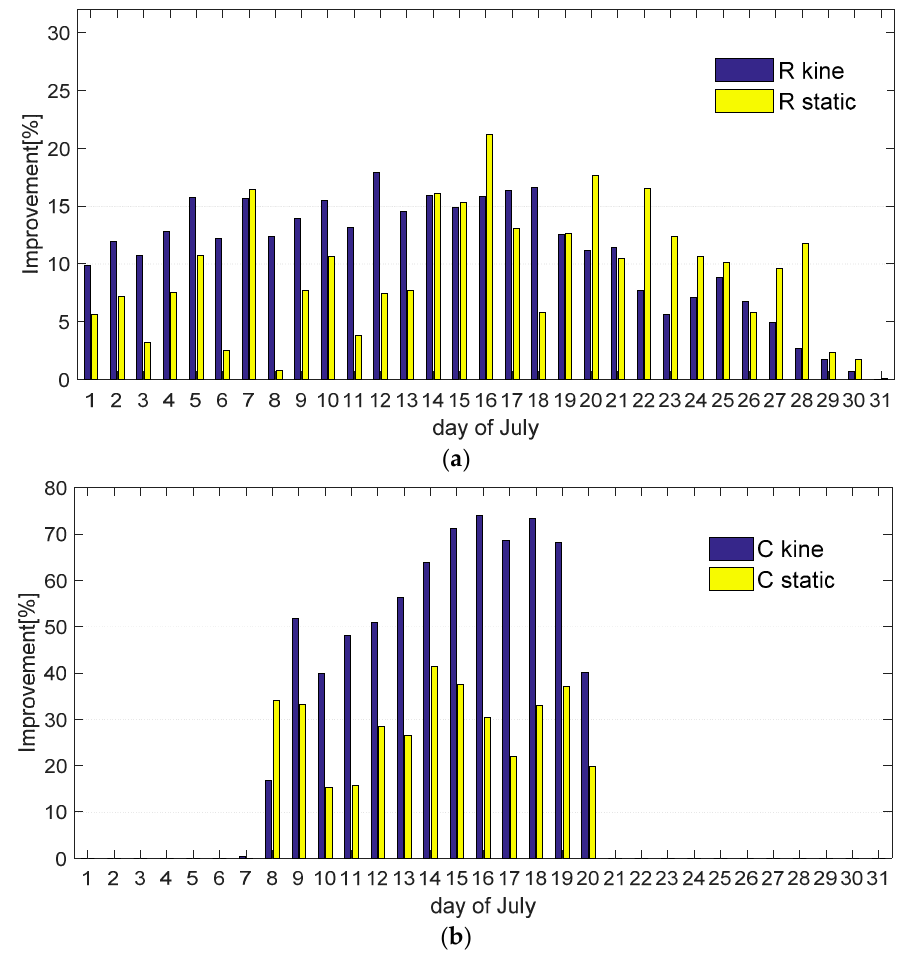
Figure 14. The 3D positioning accuracy improvements of S3 relative to S2 for every day in July 2017: ( a ) GLONASS-only PPP; and ( b ) BDS-only PPP. The dark blue represents the PPP dynamic mode while the yellow represents the PPP static mode.